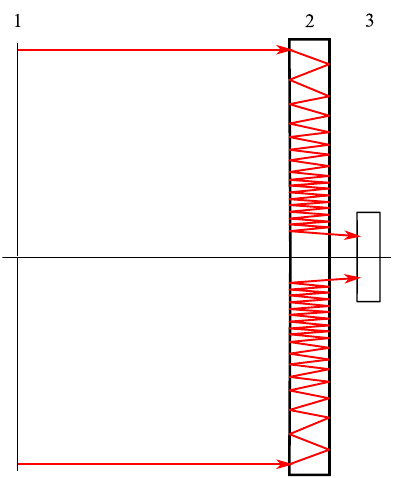
Figure 11. An optical setup for image acquisition using an optical system with annular aperture. 1, a test pattern illuminated by a planar uniform light source; 2, an annular imaging system; and 3, a recording camera ToupCam UCMOS03100KPA.